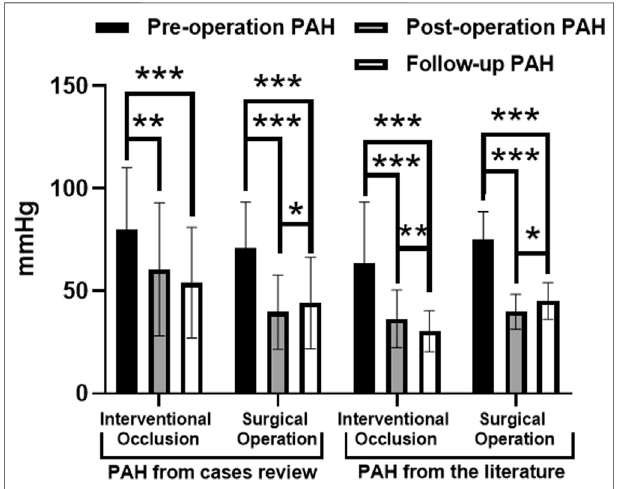
FIGURE 3 | PAH in case review and nine studies between interventional occlusion and surgical operation including preoperation, postoperation,